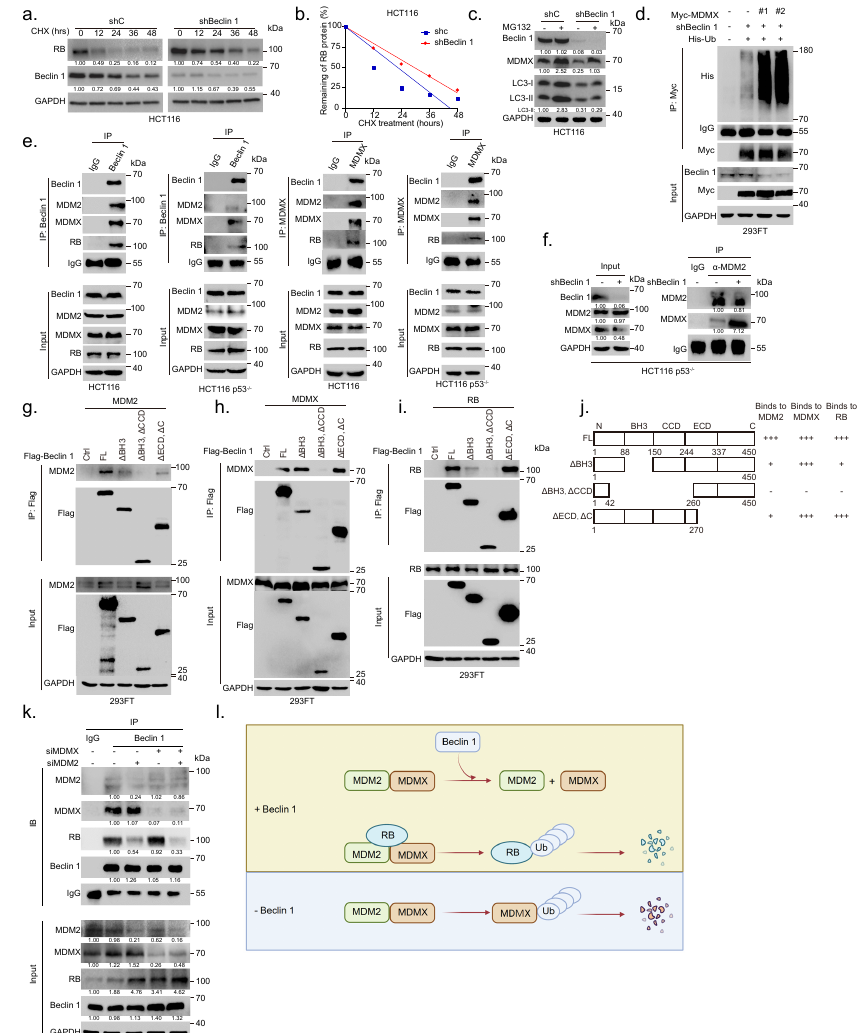
Figure 4. Ablation of BECN1 facilities MDM2–MDMX interaction to promote MDMX degradation and RB protein stabilization. ( a ) HCT116 cells stably expressing shBeclin 1 or control shRNA (shC) were treated with 50 µg/mL cycloheximide (CHX) for the indicated time intervals. ( b ) The plots of RB protein half-life. ( c ) HCT116 cells stably expressing shBeclin 1 or control shRNA (shC) were treated with 20 µ M MG132 for 12 h before collection. Total cell lysates were subjected to western blot. ( d ) 293FT cells stably expressing shC or shBeclin 1 (#1 or #2) were transfected with expressing plasmids of Myc-MDMX, His-Ub. Then, cells were treated with 20 µ M MG132 for 6 h before collection. Ubiquitylation of MDMX was examined by IP-western analyses. ( e ) HCT116 or HCT116 p53 − / − cells were subjected to co-immunoprecipitation (co-IP) using either a specific antibody for Beclin 1 and MDMX or IgG control followed by western blot analyses. ( f ) HCT116 p53 − / − cells stably expressing shC or shBeclin 1 were subjected to co-immunoprecipitation (co-IP) assay using a specific antibody for MDM2 or IgG control followed by western blot analyses as indicated. ( g – j ) 293FT cells were co-transfected with Flag-Beclin 1 (FL) or an indicated Beclin 1 deletion construct and MDM2 ( g ), MDMX ( h ), or RB ( i ). Total cell lysates were subjected to IP-western analyses. ( j ) A schematic illustration shows MDM2–Beclin 1, MDMX–Beclin 1, and RB–Beclin 1 interaction domains. ( k ) HCT116 p53 − / − cells transfected with siMDM2, siMDMX, siMDM2/siMDMX were subjected to co-immunoprecipitation (co-IP) using a specific antibody followed by western blot analyses as indicated. ( l ) A sketch depicts a model of the influence of Beclin 1 on quadruple protein complexes formation among Beclin 1, RB, MDMX, and MDM2. The uncropped blots and molecular weight markers are shown in Supplementary File